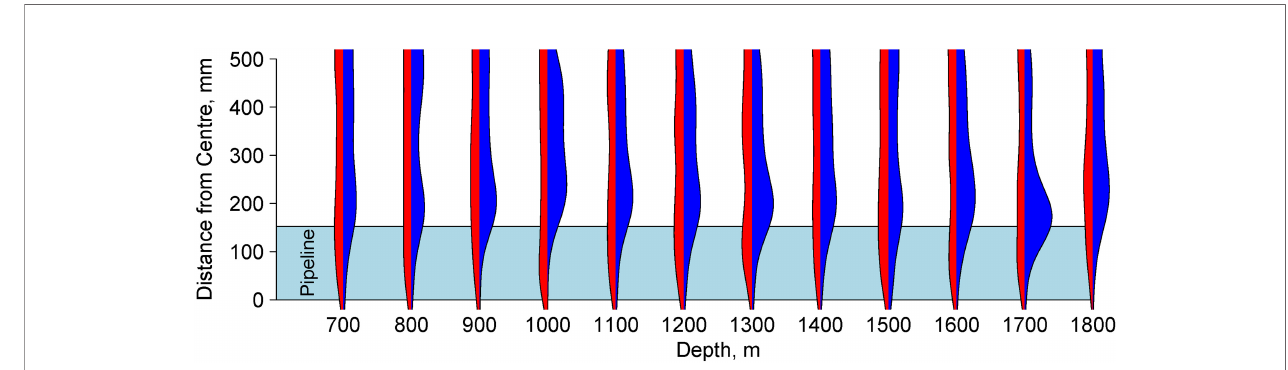
FIGURE 5 | Beanplot of density of megafauna prior to pipeline installation (red; left hand side of each plot) and after pipeline installation (blue; right hand side of each plot) relative to centre of the transect for each depth zone. In 2014 this was aligned with the pipeline axis. The extent of the pipeline (at 153 mm from the centre) is shown as a light blue polygon. The density trace is smoothed using a Gaussian smoother. The increased densities of megafauna close to the edge of the pipeline are visible at all depths after pipeline installation but